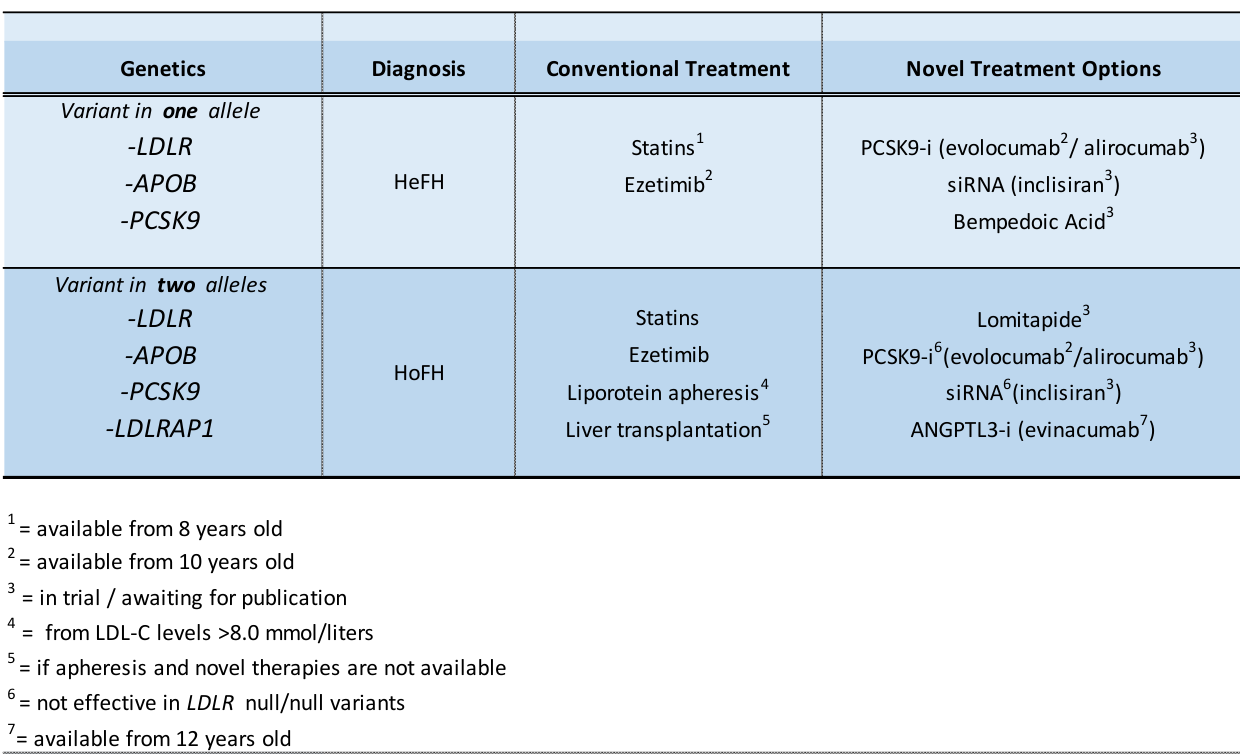
Figure 2. Genetic diagnosis and conventional/novel treatment options for children with FH .